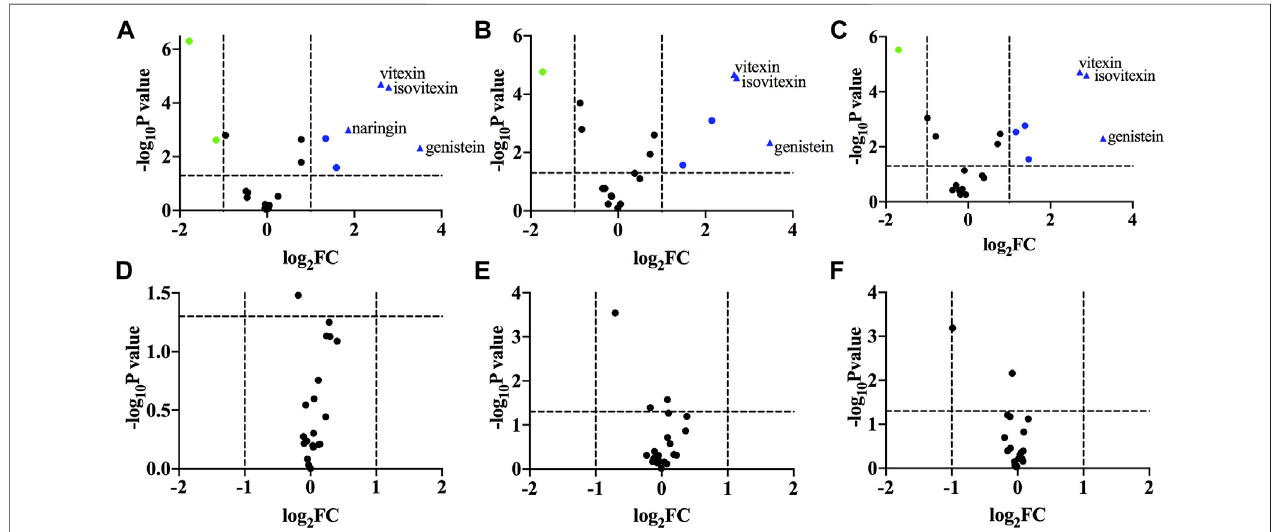
FIGURE3| Volcanoplot. (A) avs.b; (B) avs.c; (C) avs.d; (D) bvs.c; (E) bvs.d; (F) cvs. (D)(A) representsbio-enzymaticmethod; (B) representsre fl uxmethod; (C) represents ultrasonic method; (D) represents ultrasound-assisted enzymatic